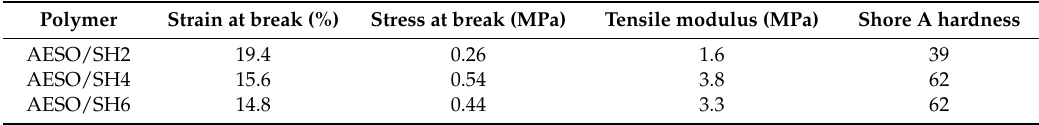
Table 3. Mechanical characteristics of cross-linked